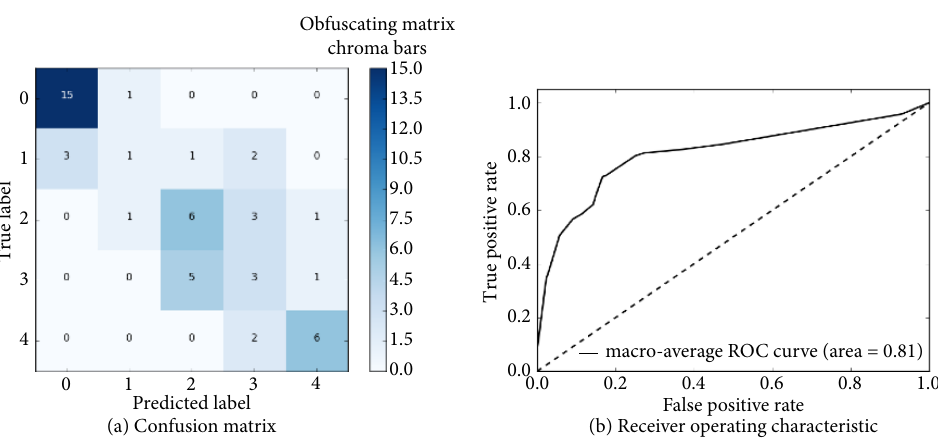
Fig. 4 Confusion matrix and ROC curve of decision tree classification.